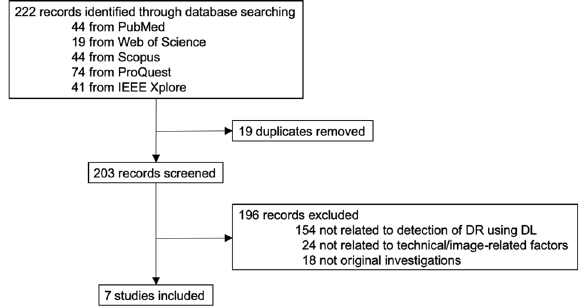
Fig. 1 Study selection. Flowchart detailing the systematic literature review conducted to identify suitable studies that have evaluated